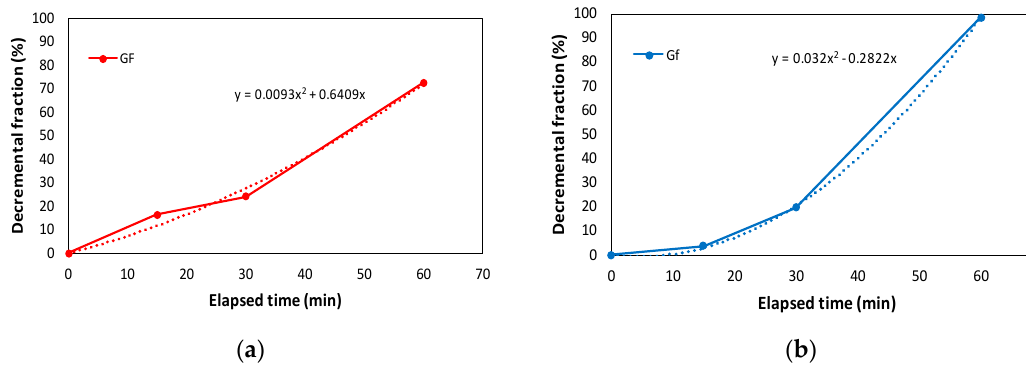
Figure 12. Comparison of G F , G f : ( a ) true fracture energy ( G F ); and ( b ) size effect fracture energy ( G f ).